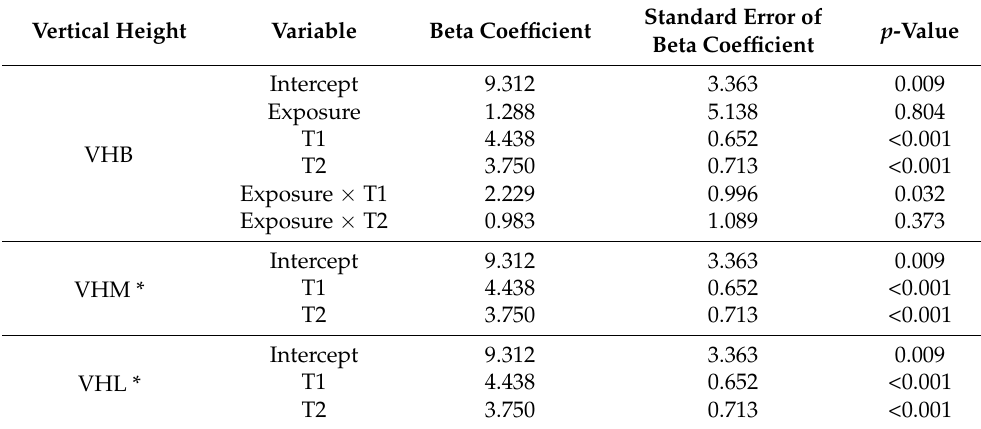
Table 3. Generalized least square method for evaluate the vertical height according to groups and time.